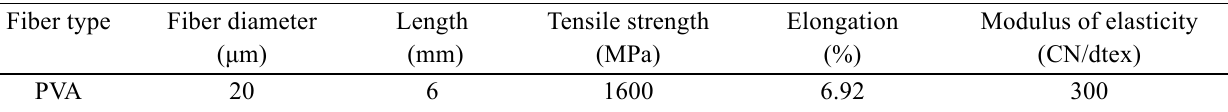
Table 2. Physical and mechanical properties of PVA